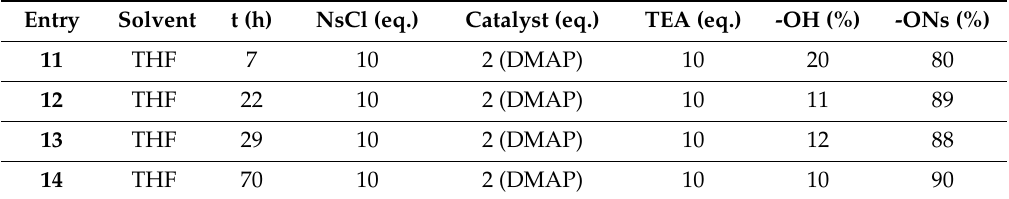
Table 2. The e ff ect of the reaction conditions on the nosylation of PIB exo -OH at room